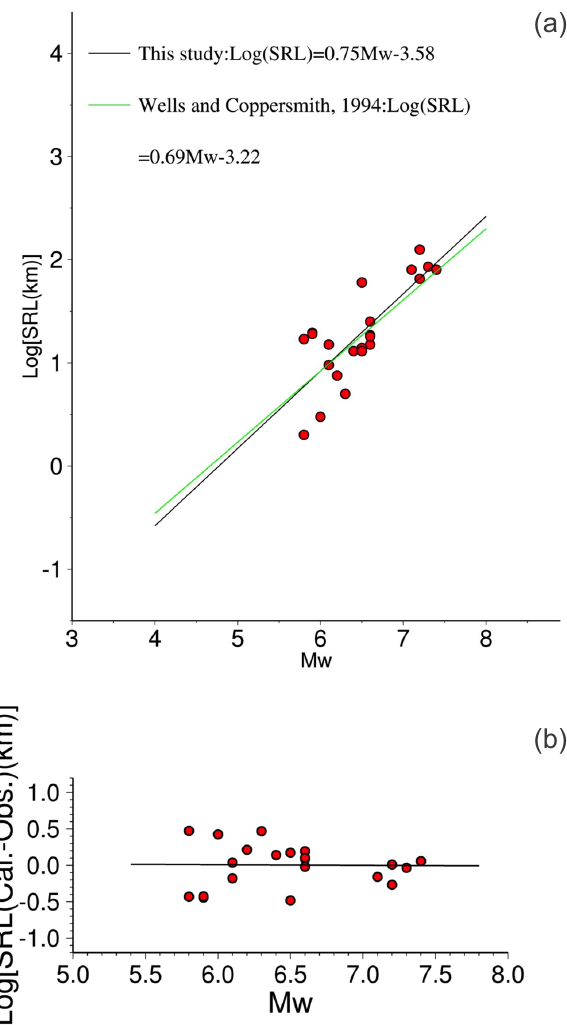
using 22 Iranian inter- Figure 9. (a) Variation of the logarithm of the subsurface coseismic W fault length, SSRL (in km), as a function of M continental regions of Iran. (b) Residual test for the equation of Fig- ure 9a. Straight lines are linear fits to the data in both